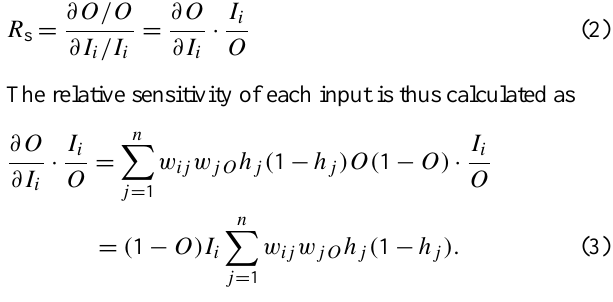
Characteristic patterns of relative sensitivity. The continuum indicated by the arrow on the left indicates the relative focus of each sensitivity characteristics on a range between global and local. 36